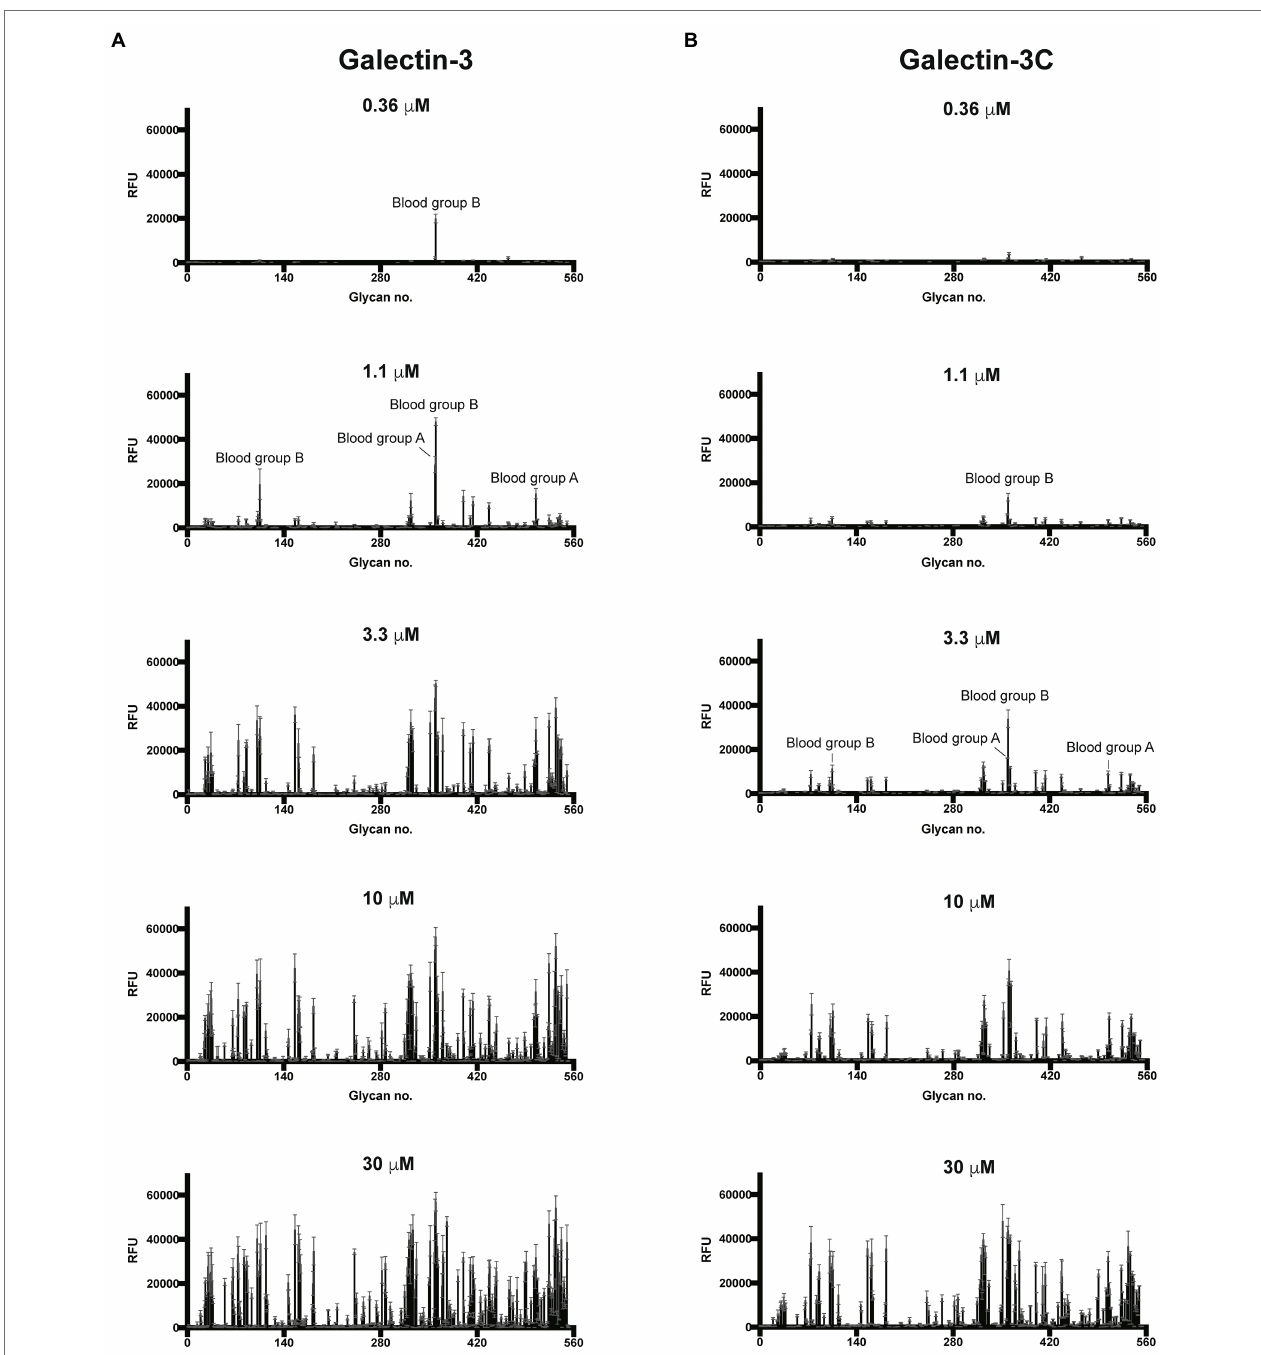
FIGURE 1 | Gal-3 and Gal-3C preferentially recognize blood group antigens at distinct concentrations. Consortium for functional glycomics (CFG) glycan microarray data obtained after incubation with the indicated concentrations of Gal-3 (A) and Gal-3C (B) . RFU, relative fluorescence units. Error bars represent means ± standard deviation